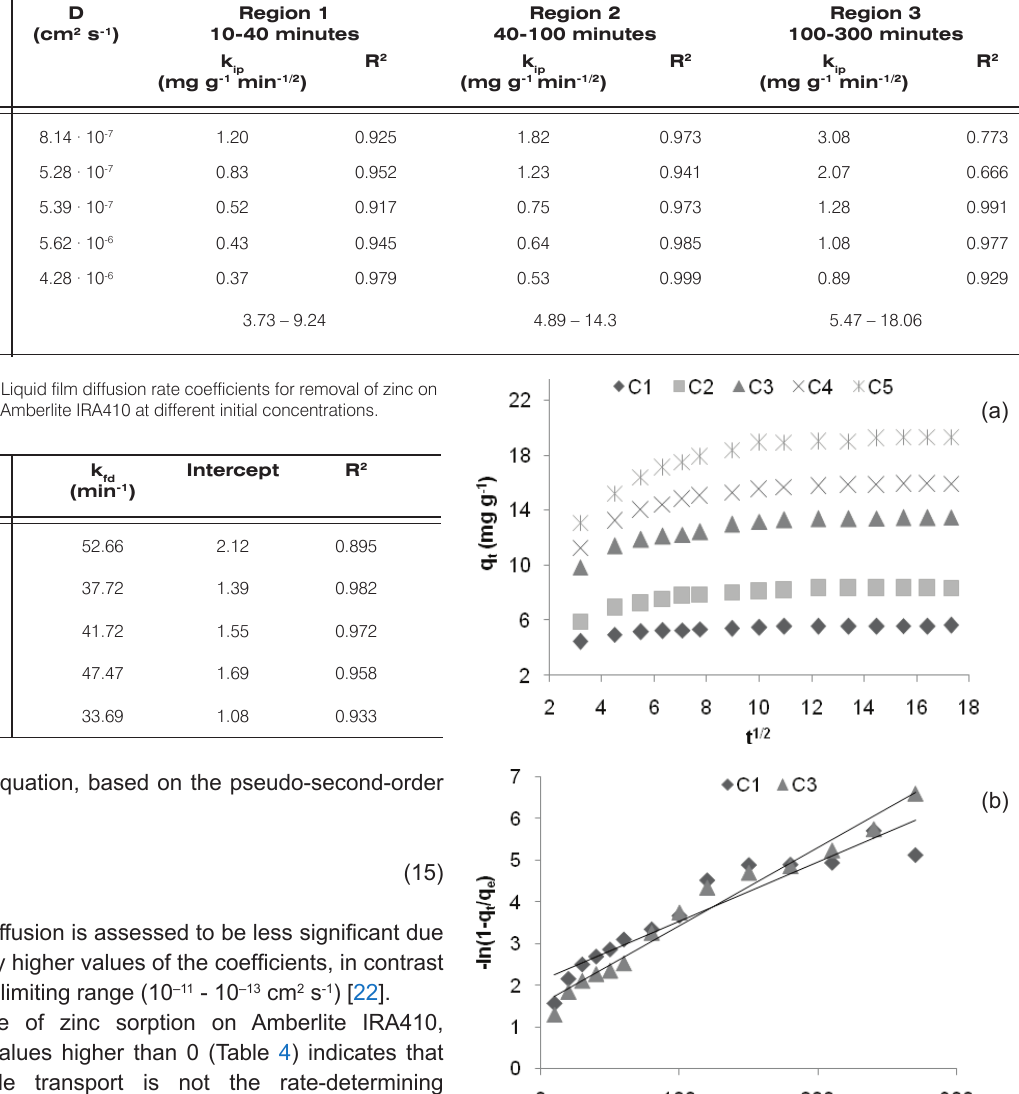
be concluded that neither liquid film diffusion is rate- determining step (intercept values are higher than process.